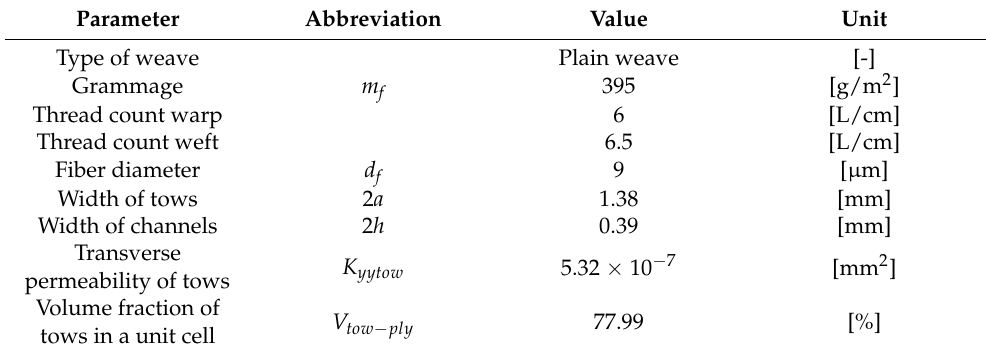
Table 1. Measured and calculated parameters of the fabric.